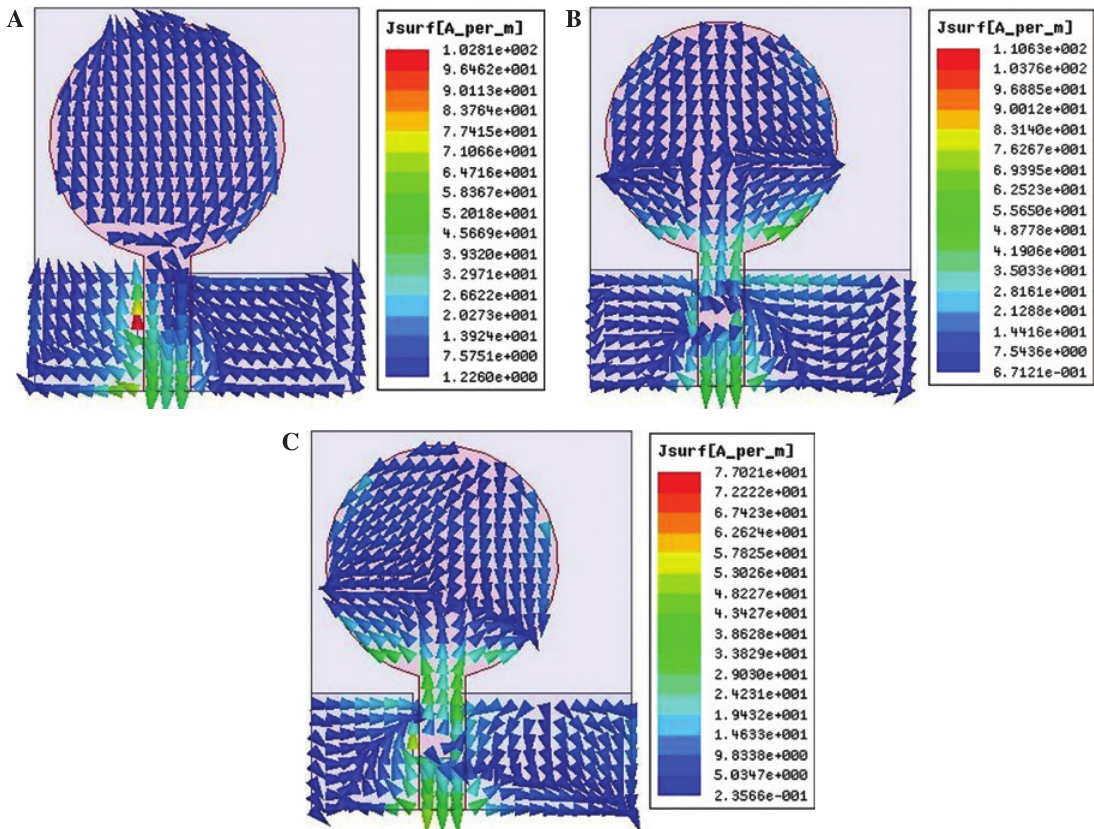
Figure 13: Surface current distribution at (A) 3.7 GHz, (B) 7.3 GHz, and (C) 9.2